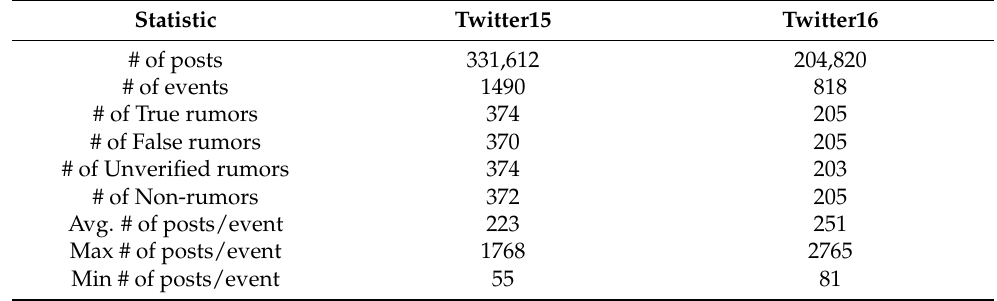
Table 1. Statistics of the datasets.